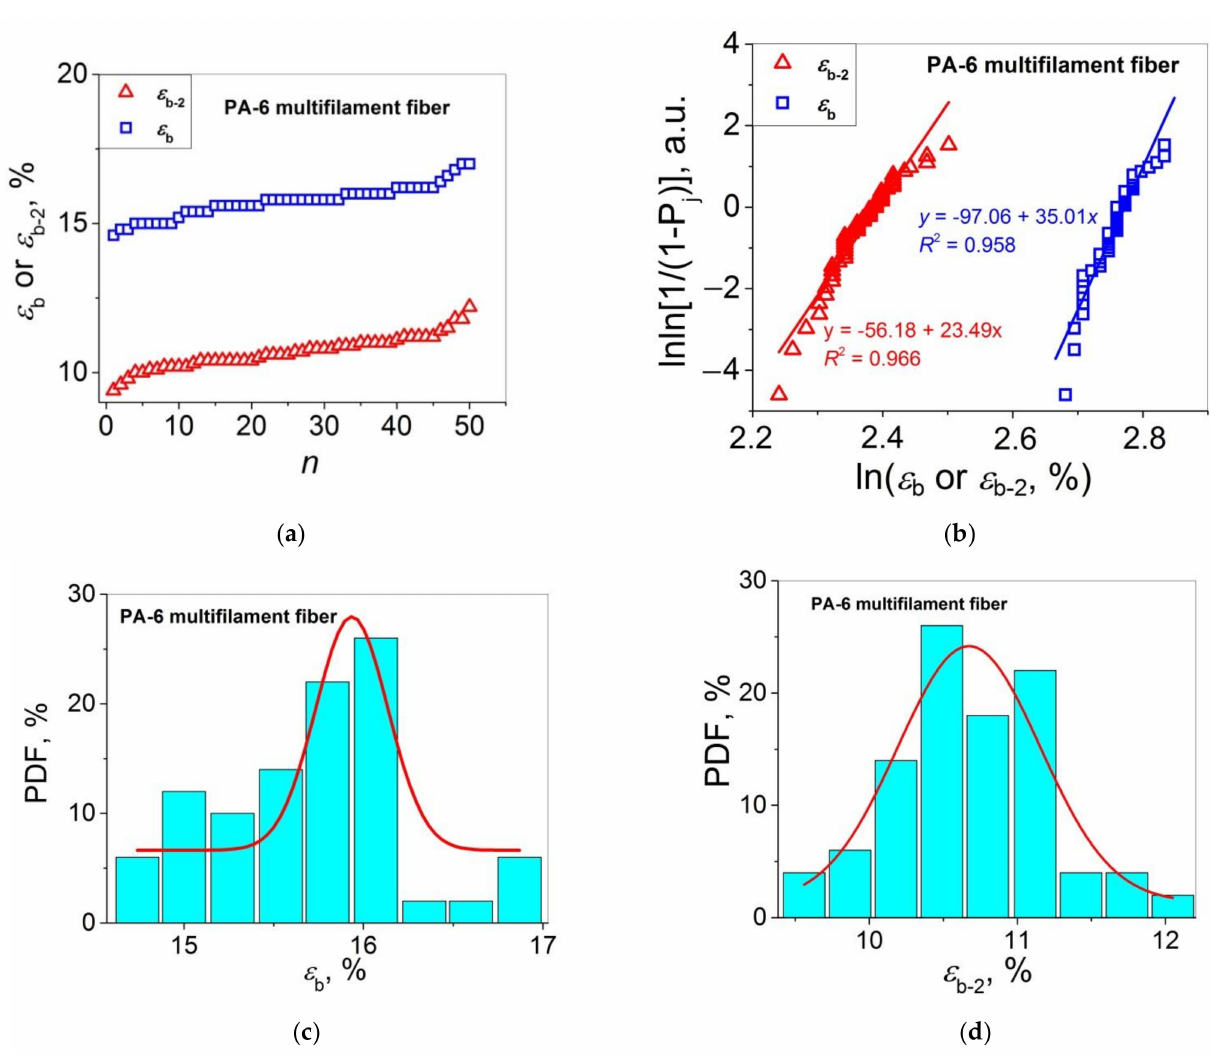
Figure 6. ( a ) Strains at break ε b and ε b-2 as functions of sample number n in an ascending order for PA 6 multifilament fibers; ( b ) Weibull’s plots for the data presented in ( a ); PDF vs. ε b ( c ) and ε b-2 ( d ) for the data presented in ( a ); the bell curves are the Gaussian fitting